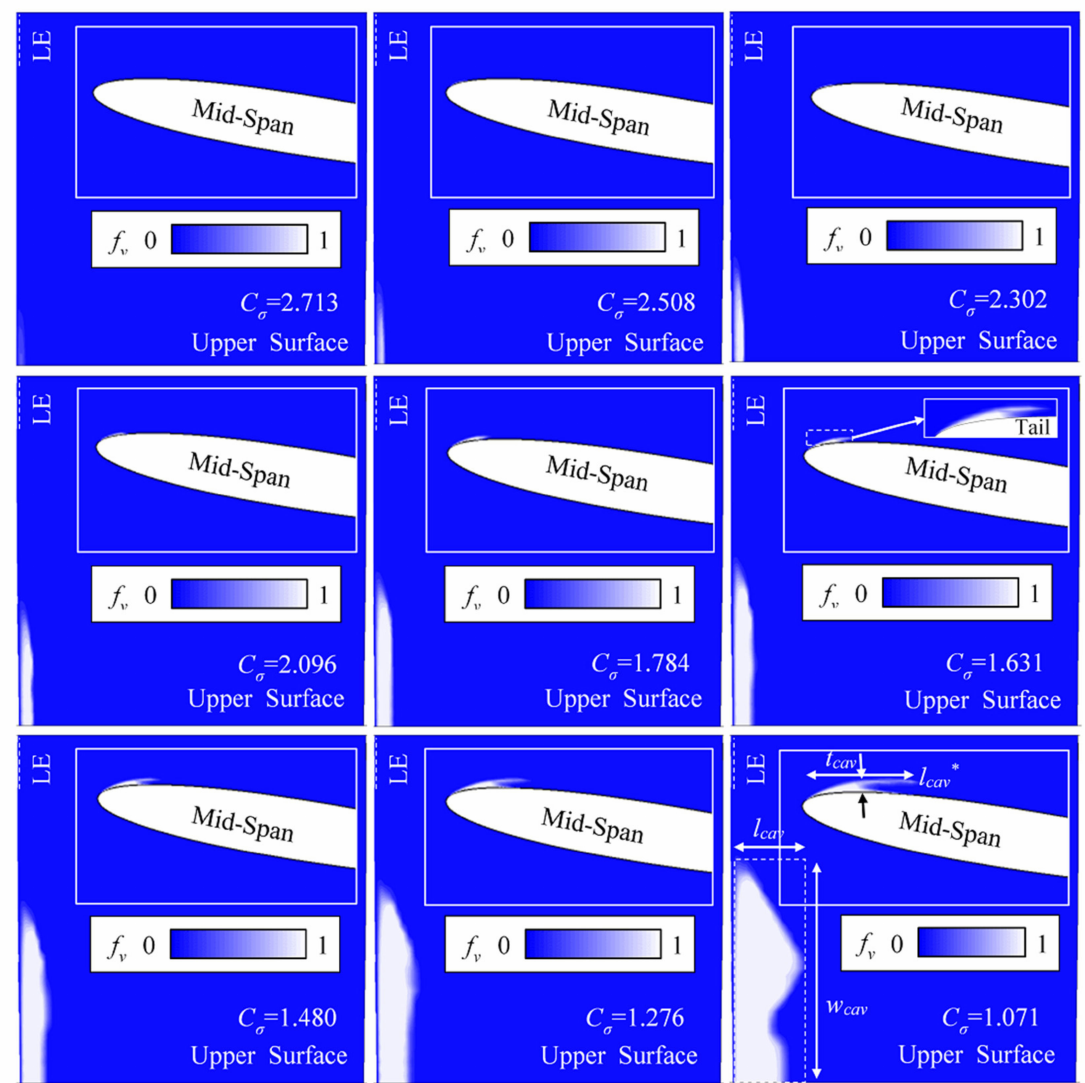
Figure 11. Variation of the cavitation vapor volume fraction f v on the mid-span plane and foil upper surface with the decreasing of cavitation coefficient C σ . LE: